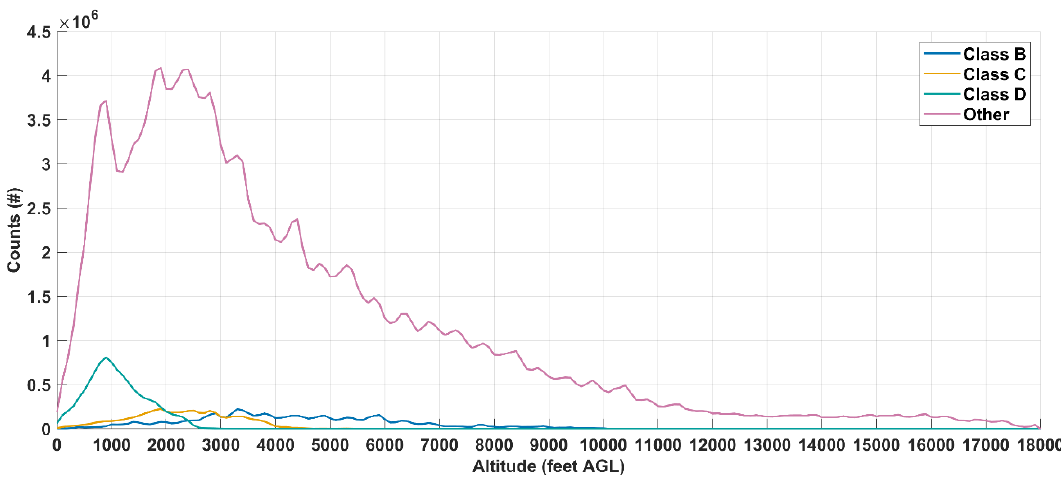
Figure 3. Altitude and airspace distributions for fixed wing single engine aircraft below 18,000